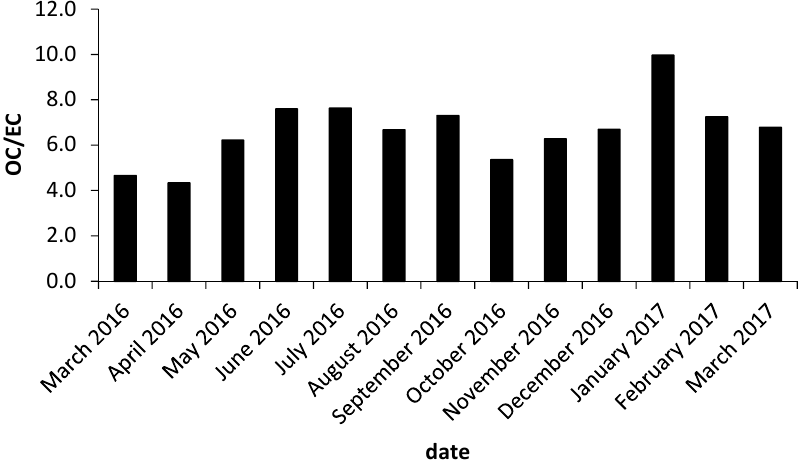
Figure 6. Monthly mean variation of the OC/EC ratio.